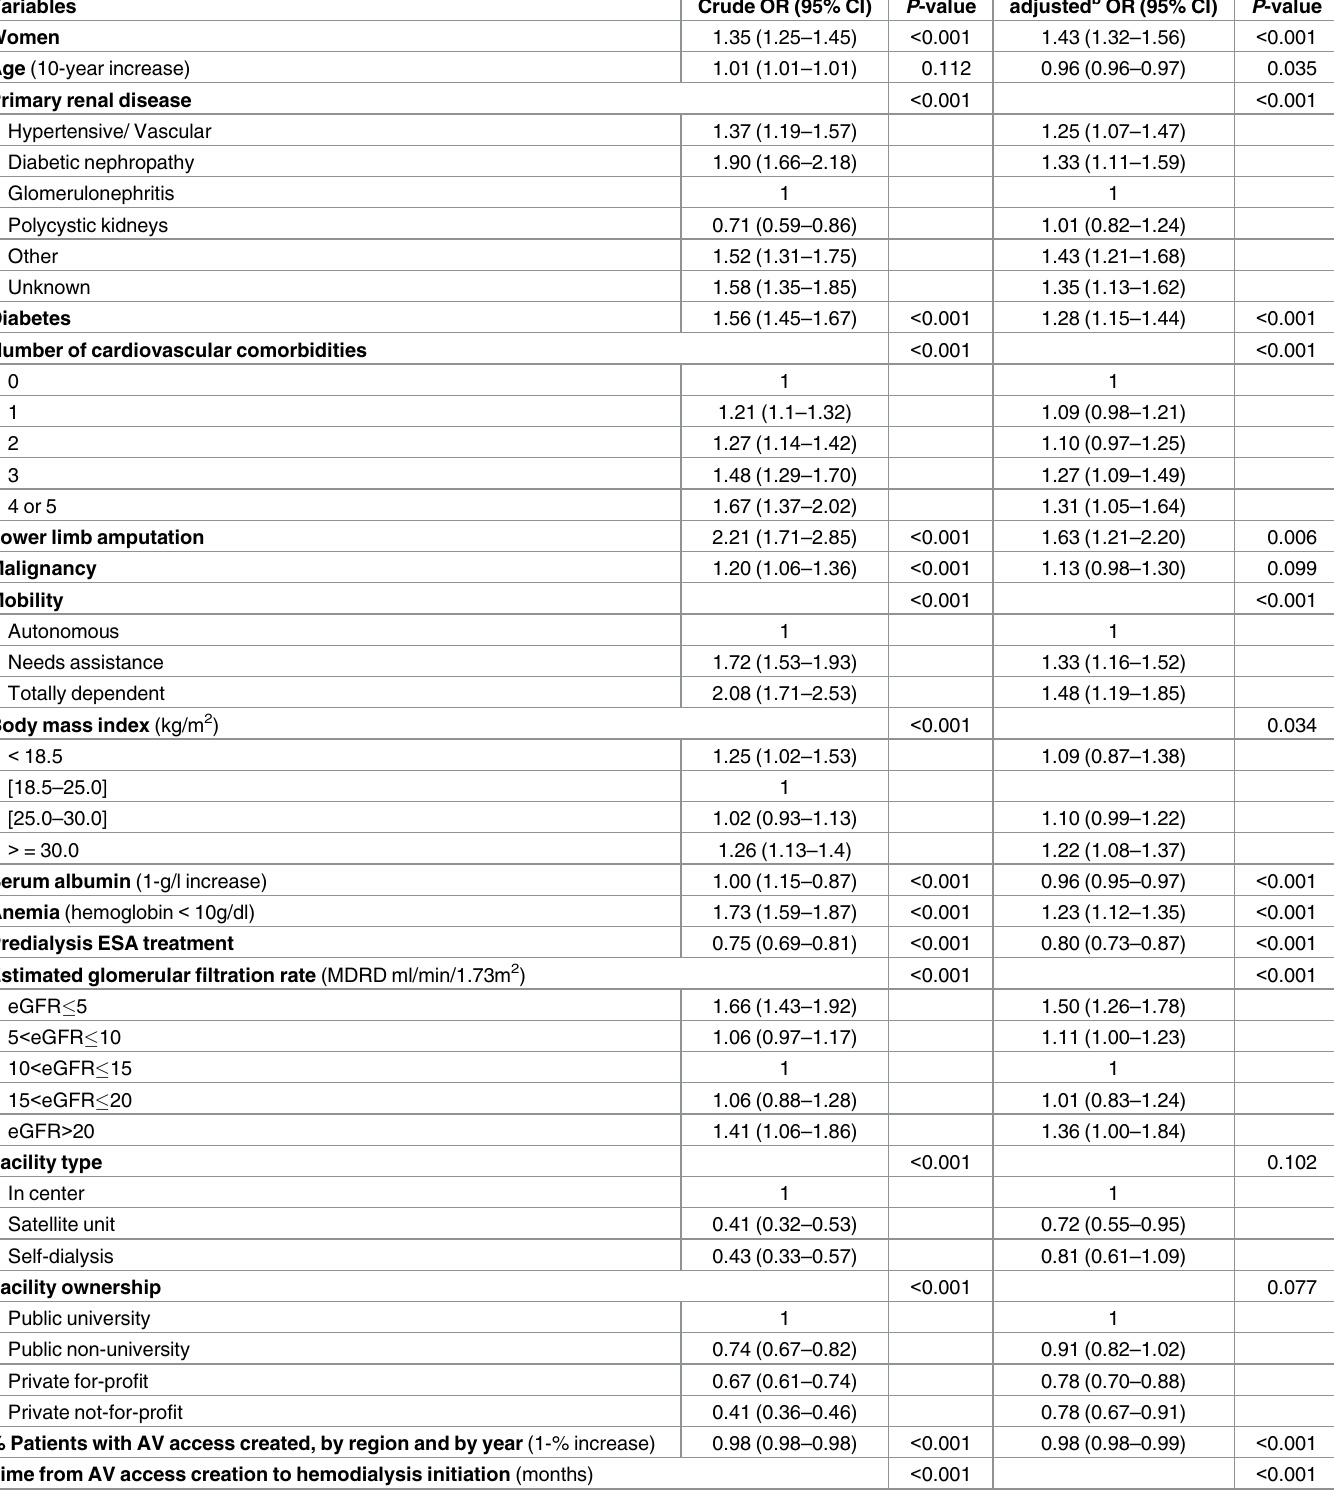
Table 2. Determinants of nonfunctional arteriovenous accessin patients with a planned dialysis start (n a = 25